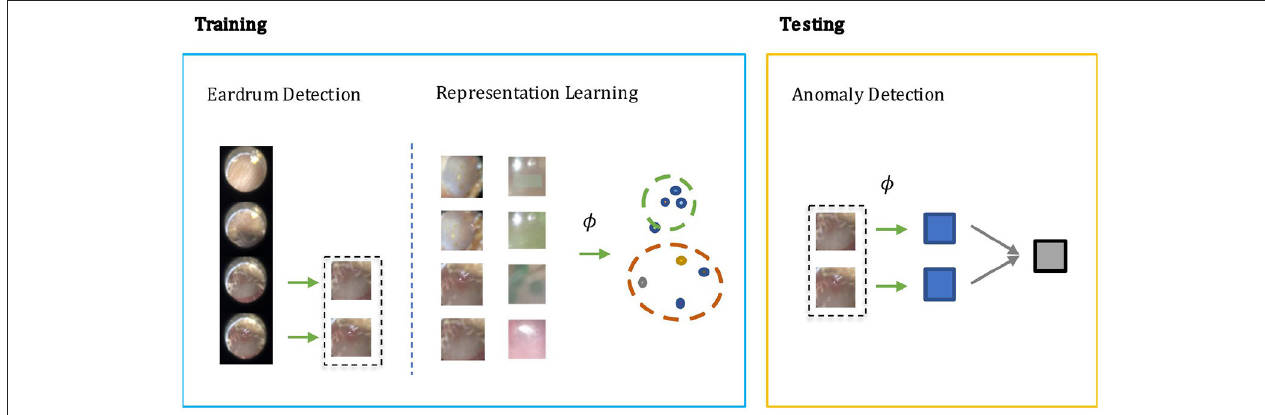
FIGURE 1 | The screening architecture of our shift contrastive anomaly detection (SCAD) is composed of three sub-blocks: eardrum detection, representation learning, and anomaly detection. During training, eardrum detection is learned by supervised training with provided labels. Representation learning is conducted with self-supervision to obtain an embedding function φ . Both detection network and embedding function network are convolutional neural network that takes an individual frame as input. During testing, we use the embedding function φ to produce a frame level anomaly score. The video level anomaly score is then obtained by aggregating image level anomaly scores of all detected eardrum frames in a